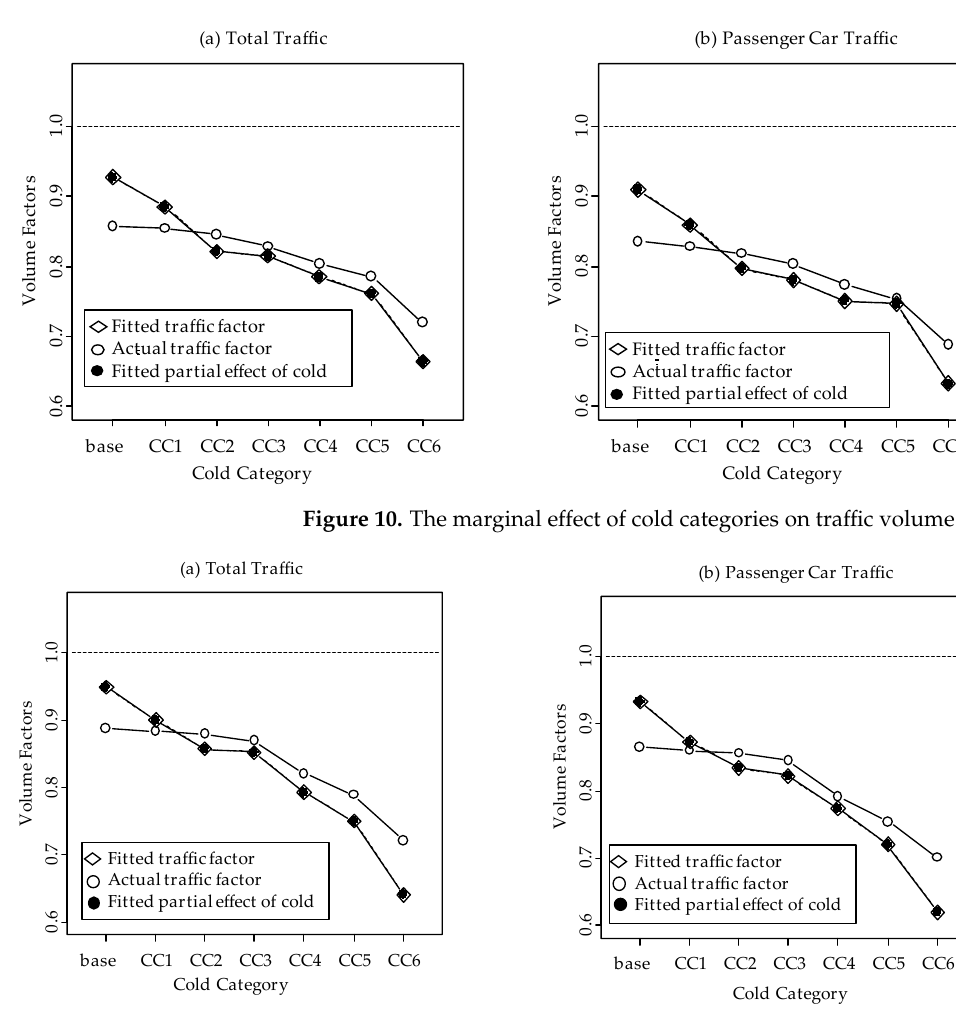
Figure 11. The marginal effect of cold categories on traffic volume factor at Red Deer Highway 2.